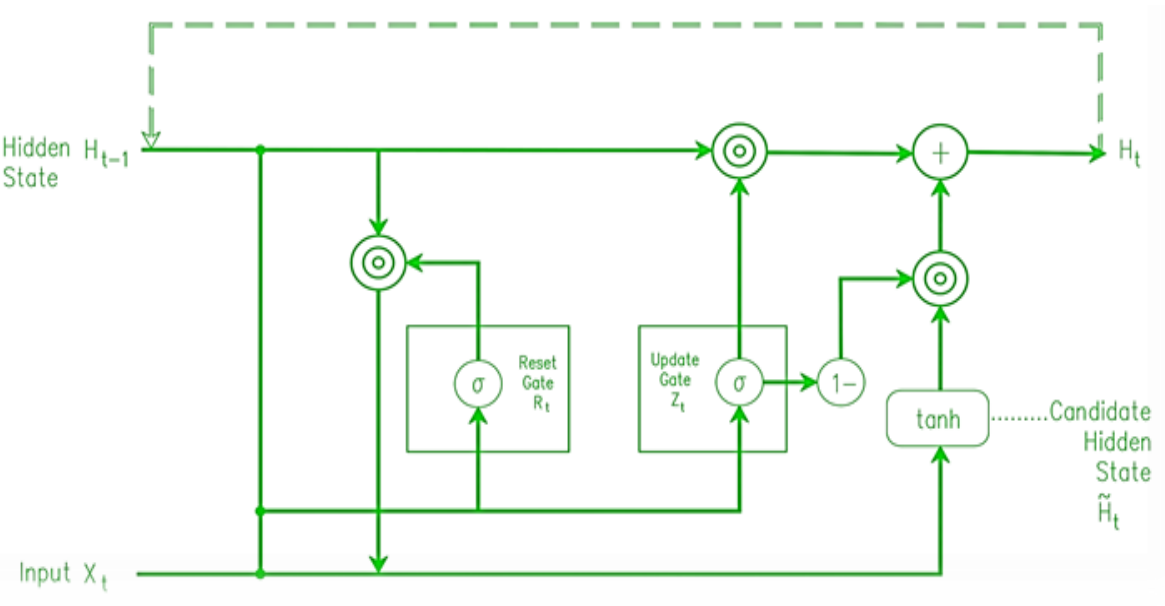
Figure 12. Basic structure of the GRU model.